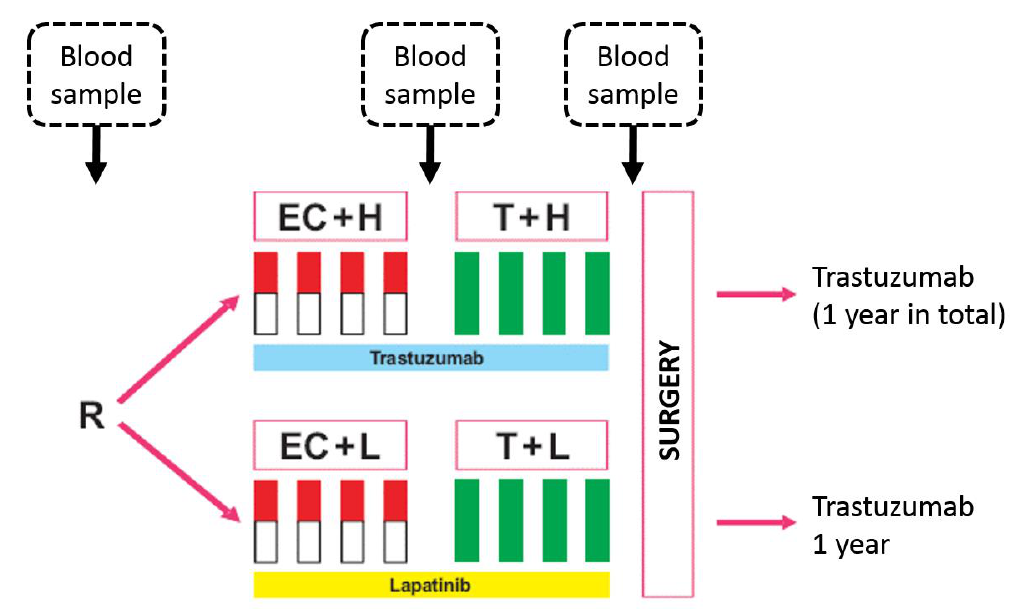
Figure 1. Serum collection in the HER2-positive cohort in the GeparQuinto trial.Abbreviations: EC– epirubicin/cyclophosphamide, T–docetaxel, H–trastuzumab, L–lapatinib.